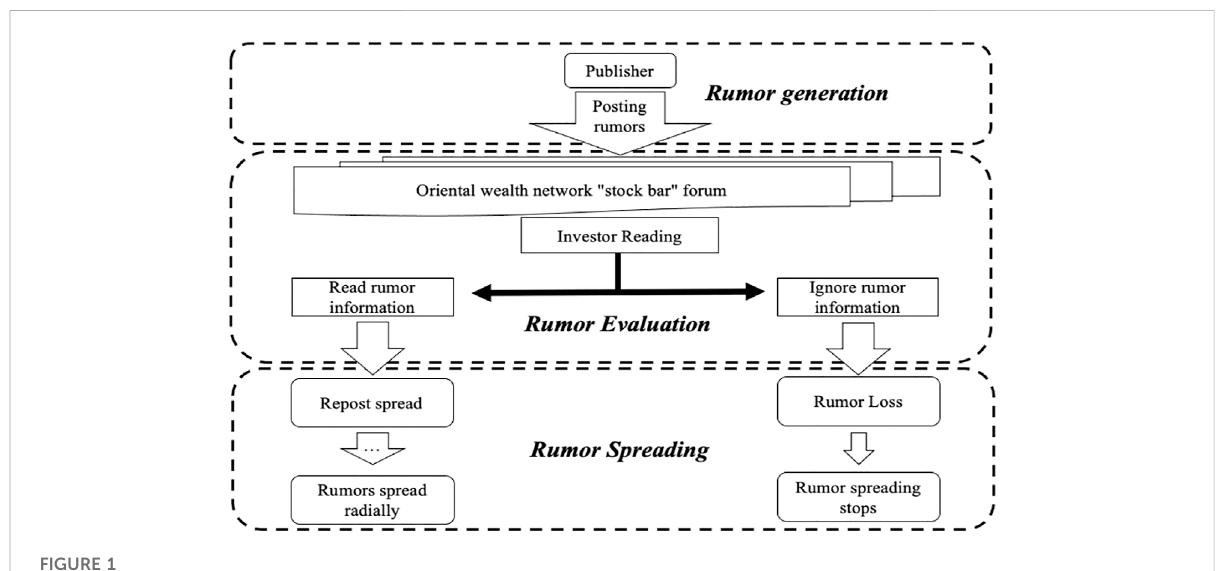
FIGURE 1 Rumor spreading behavior